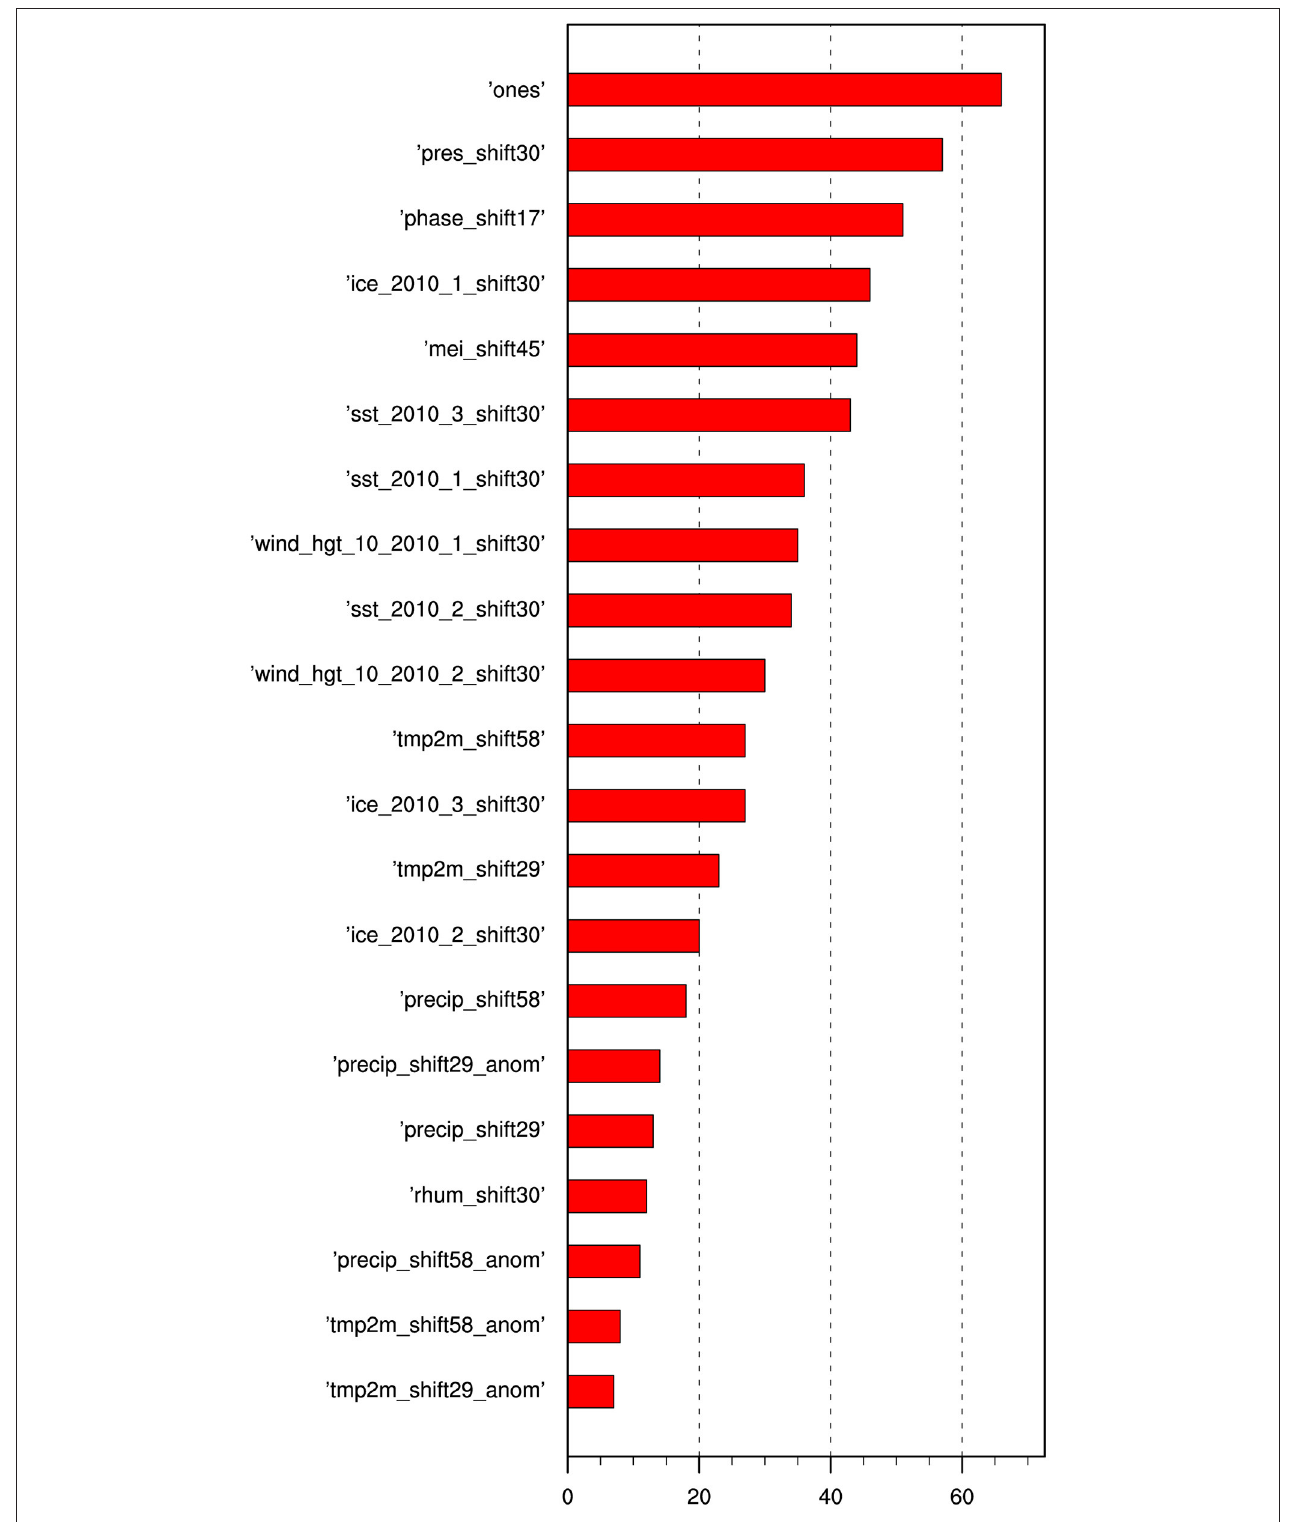
FIGURE 3 | Candidate factors inclusion frequencies selected by local linear regression with multitask feature selection (MultiLLR) models for all target dates during 2011–2016.